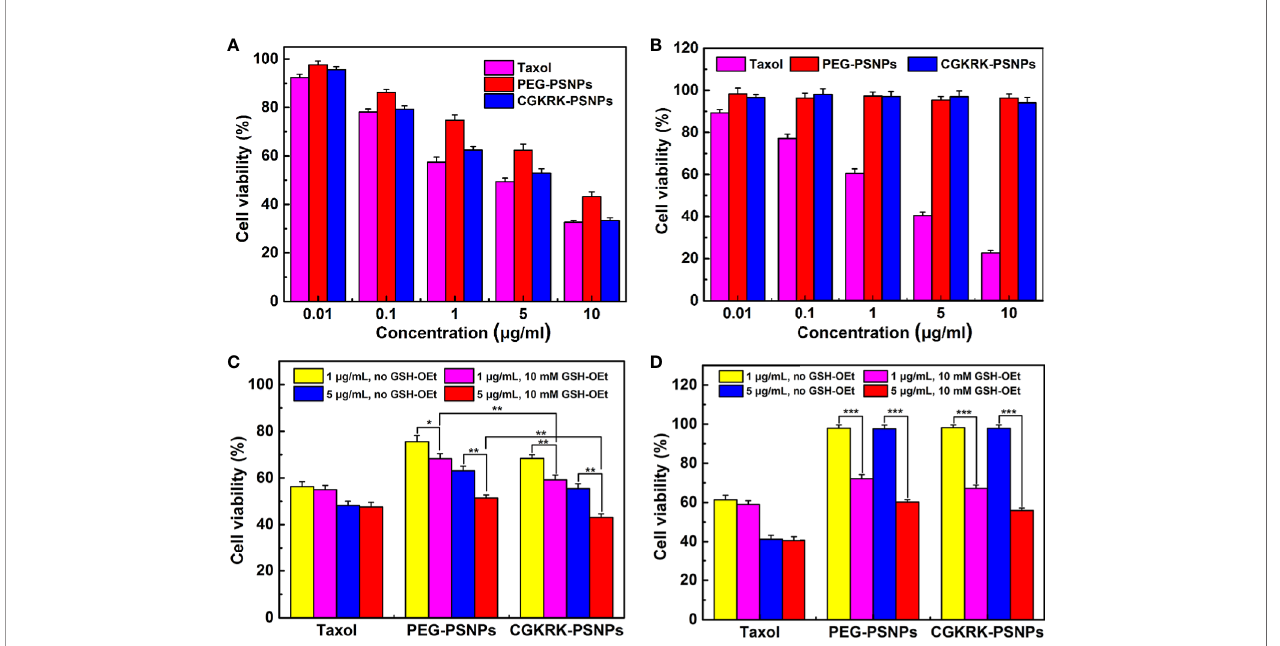
FIGURE 6 | Cytotoxicity of Taxol ® , PEG-PSNPs, and CGKRK-PSNPs in U87MG cells (A) and BCEC cells (B) after incubation for 48 h (n = 6). Viability of GSH-OEt pretreated or non-pretreated U87MG cells (C) and BCEC cells (D) incubated with Taxol ® , PEG-PSNPs and CGKRK-PSNPs for 48 h. *** P < 0.001, ** P < 0.01, * P < 0.05.